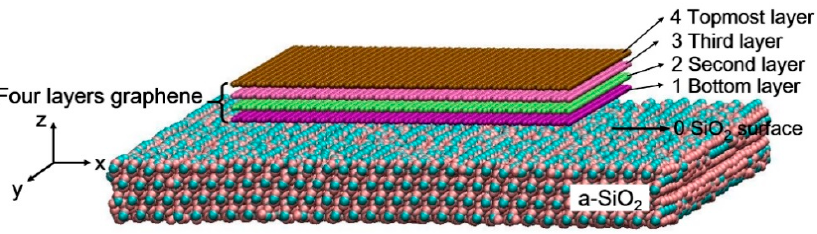
Figure 1. Molecular dynamics (MD) model of four layers graphene on a -SiO 2